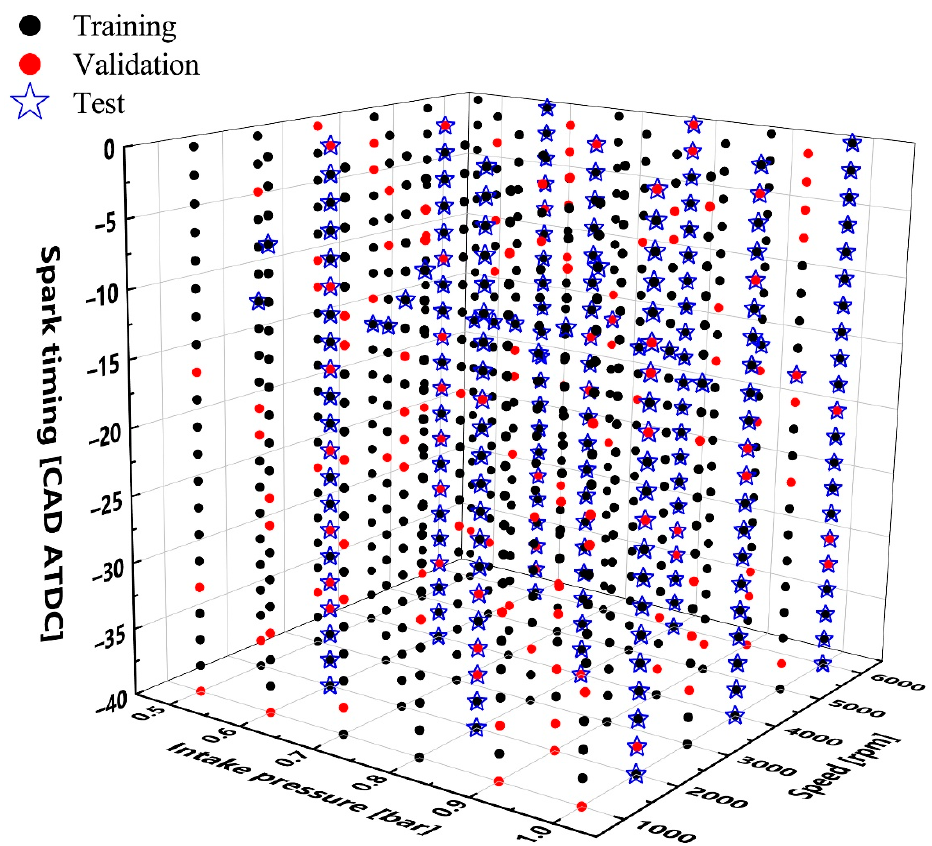
Figure 2. Training, validation and test data for ML learning algorithms.